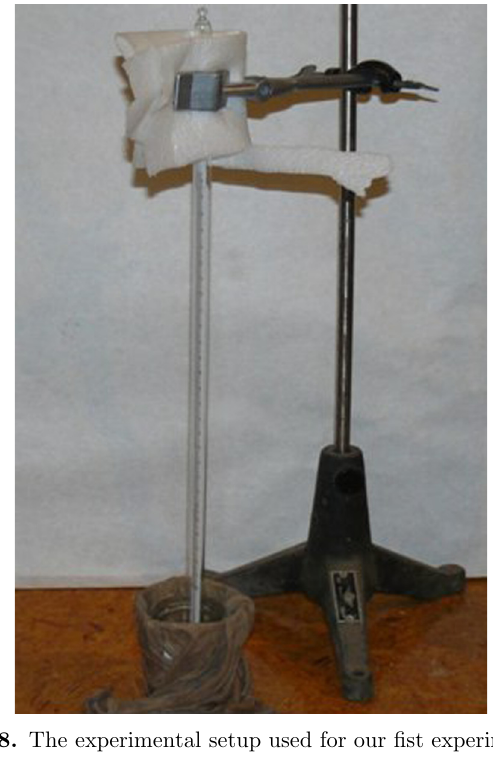
Fig. 8. The experimental setup used for our fi st experiments.